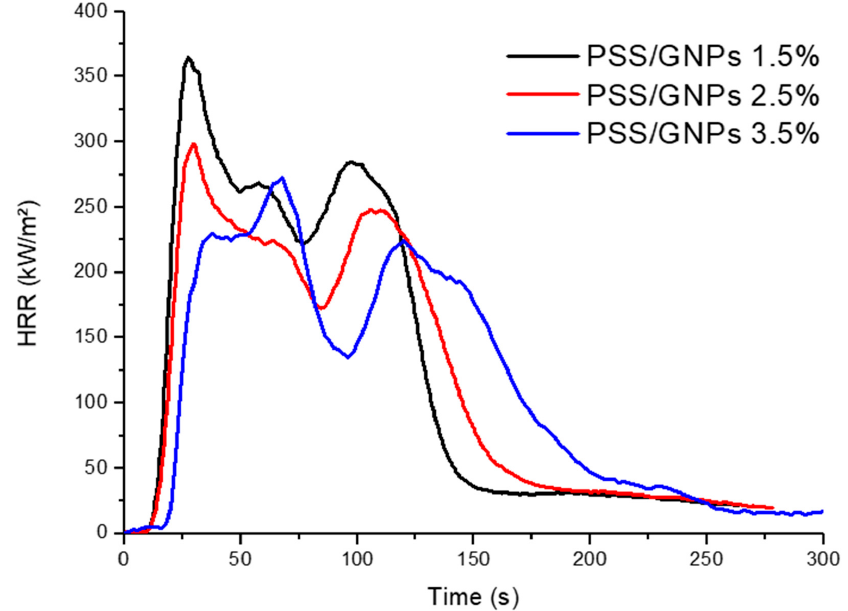
Figure 7. HRR vs. time curves for coated samples with different percentages of PSS/GNPs coating.